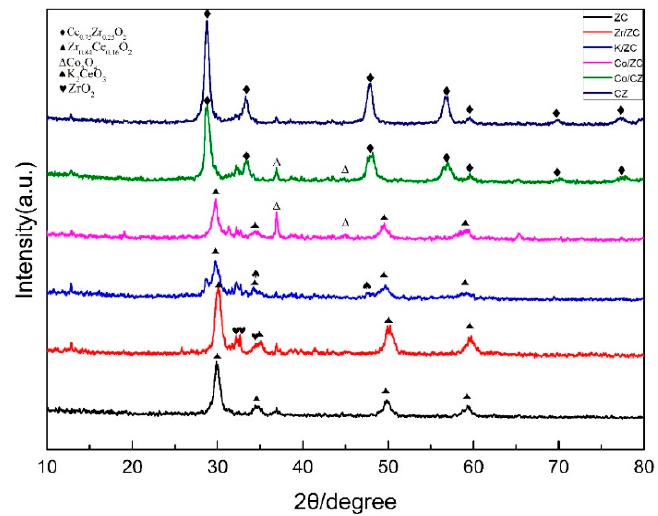
Figure 2. XRD patterns of the catalysis. Ce 0.75 Zr 0.25 O 2 (CZ), Zr 0.84 Ce 0.16 O 2 (ZC), 0.8 M of Zr(NO 3 ) 4 ·5H 2 O